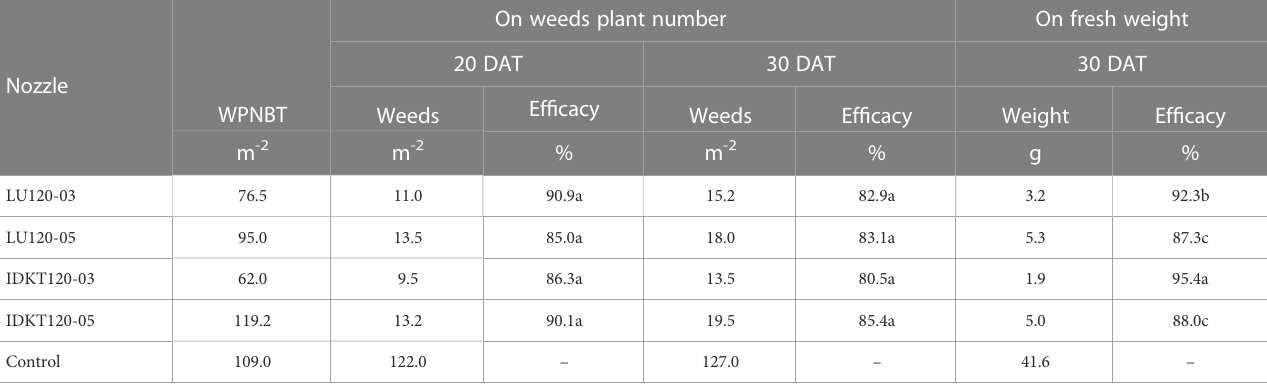
TABLE 6 Weed plant number before treatment (WPNBT), control ef fi cacy (%) on weed plant number, and fresh weight of weeds in the maize fi eld using standard fl at-fan nozzles and air-induction nozzles. On weeds plant number